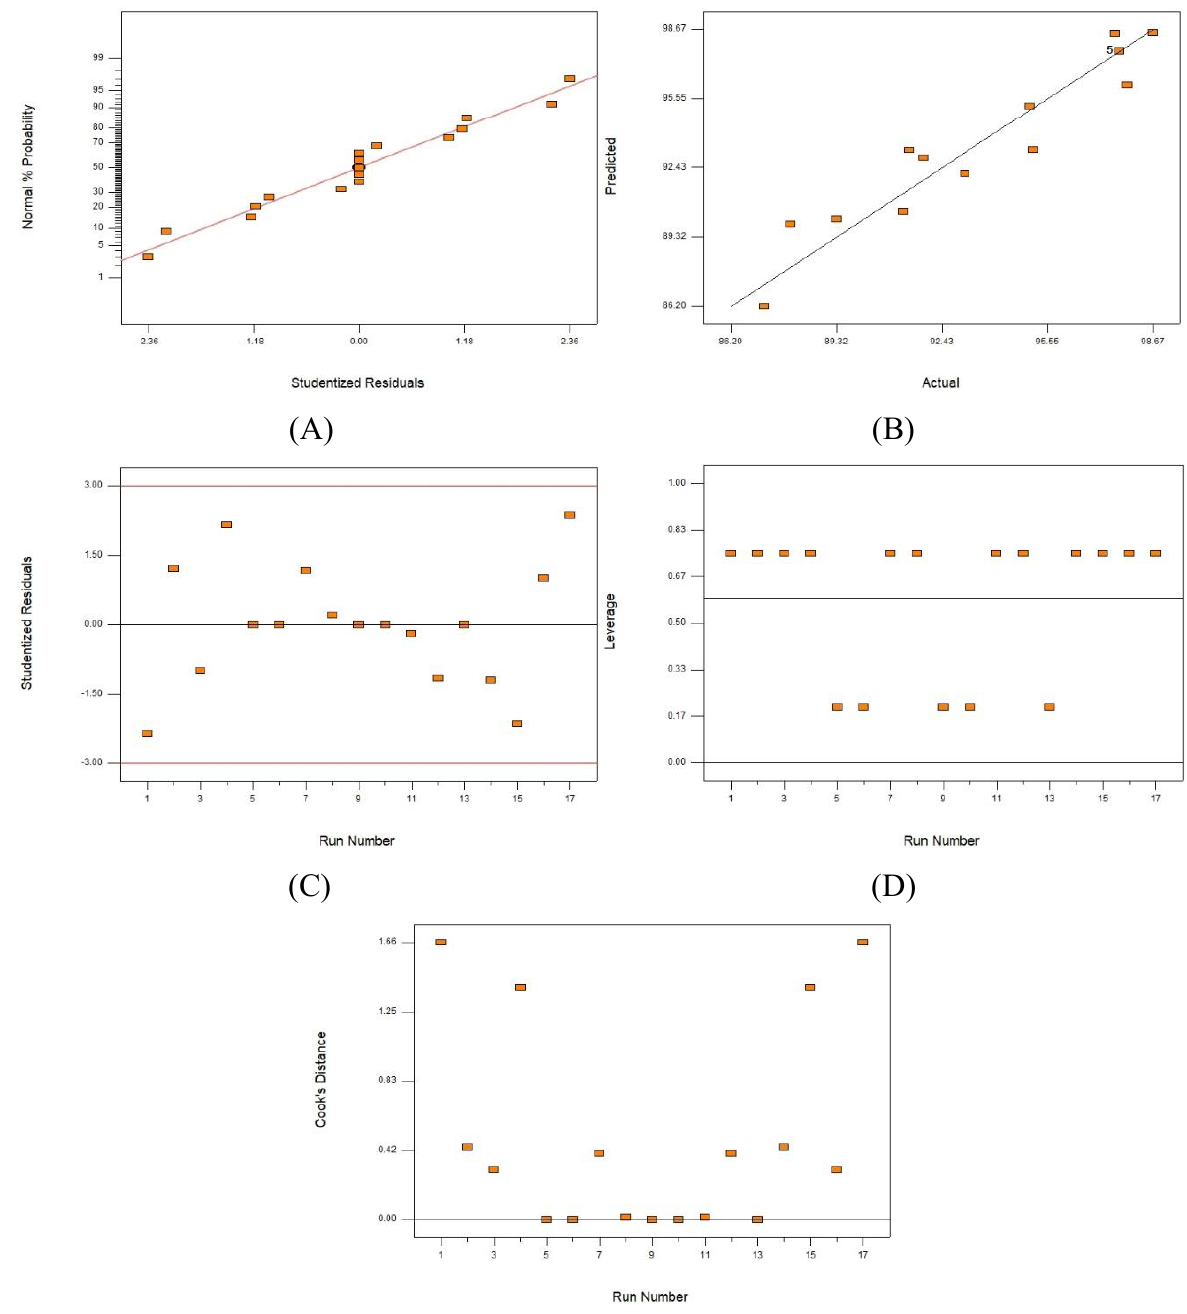
Figure 7: Diagnostic plots of Box-Behnken model adequacy.